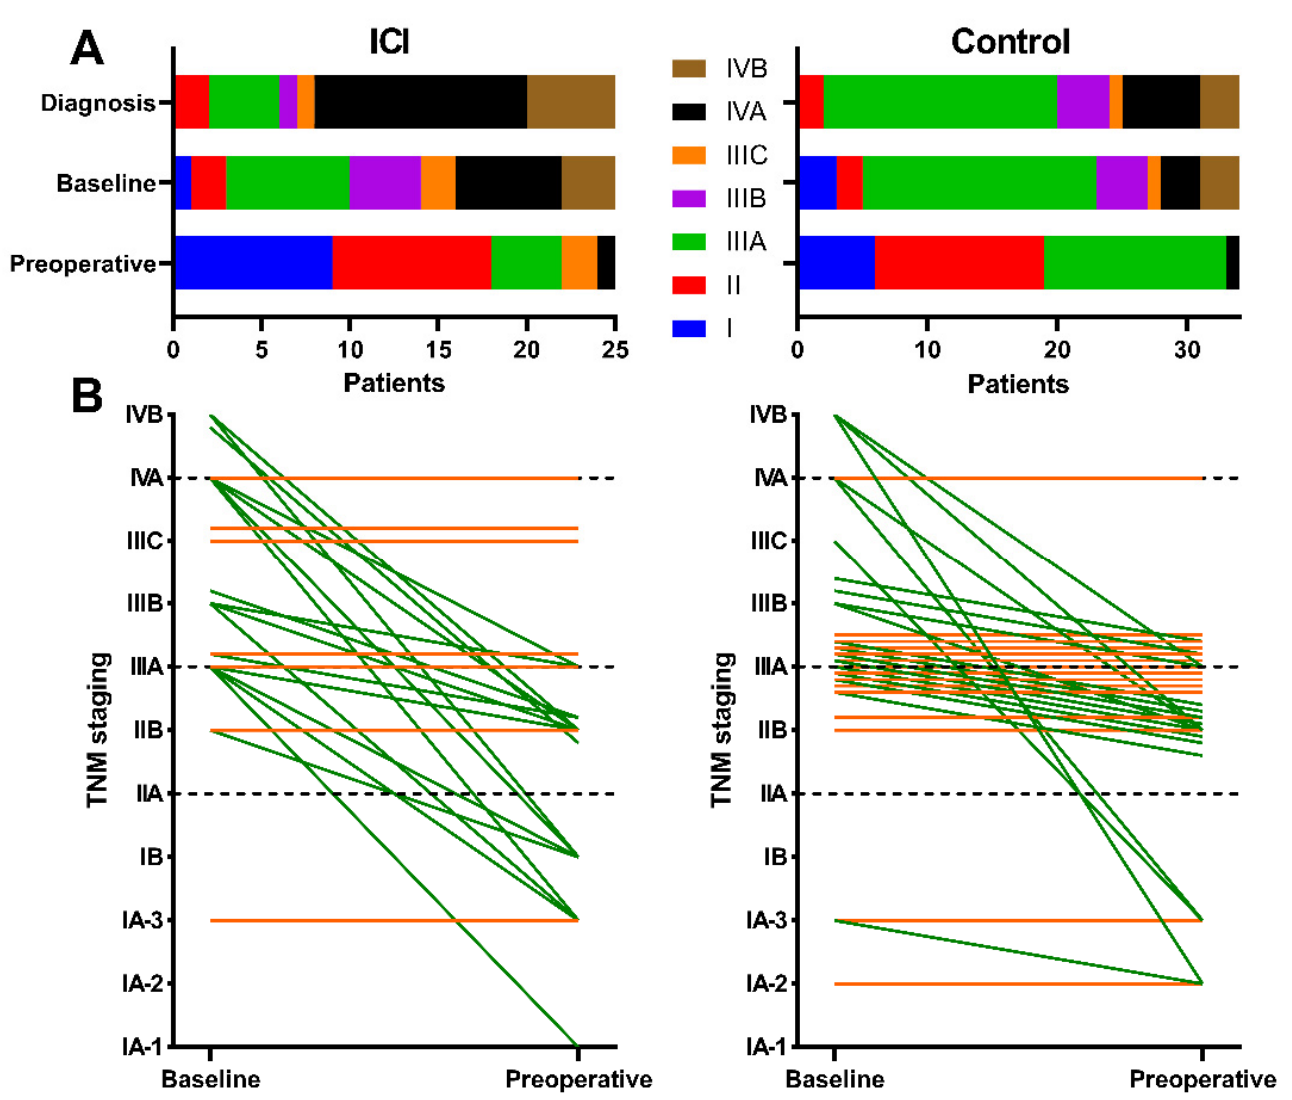
Figure 4. Evolution of clinical tumour staging in the study population. ( A ) Stacked bar chart displaying the spread of cTNM staging across patients from the ICI group at different stages of evaluation: at disease diagnosis, at ICI or chemotherapy baseline imaging, and on pre-operative evaluation. ( B ) Before-and-after graph of the evolution of cTNM cancer staging in each patient between baseline and preoperative evaluations in the ICI group ( left ) and the control group ( right ). Each line represents a single patient. Green lines signify downstaging. Orange lines represent patients without stage changes. Local treatments of oligometastases were taken into account where applicable.